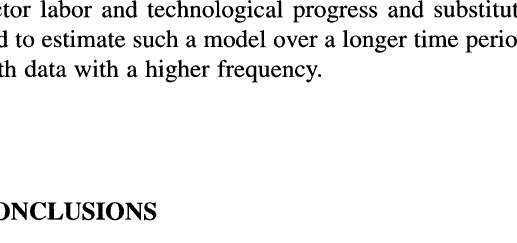
FIGURE 6 Capital-resource ratio.